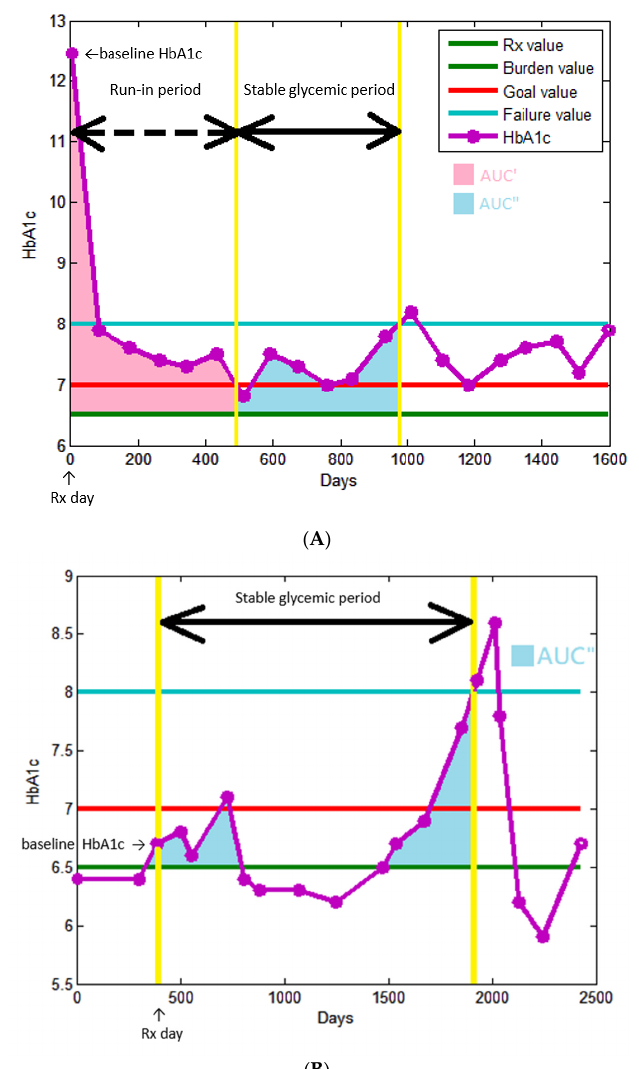
Figure 2. ( A ) An example of baseline HbA1C > 7.0%. ( B ) An example of baseline HbA1C ≤ 7.0%. Rx vale = starting treatment value. Goal value = treatment goal value. Failure value = treatment failure value.